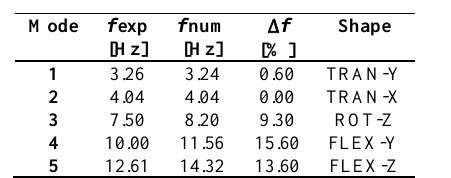
Table 3 Comparison between experimental and numerical data considering the numerical model updated to the second